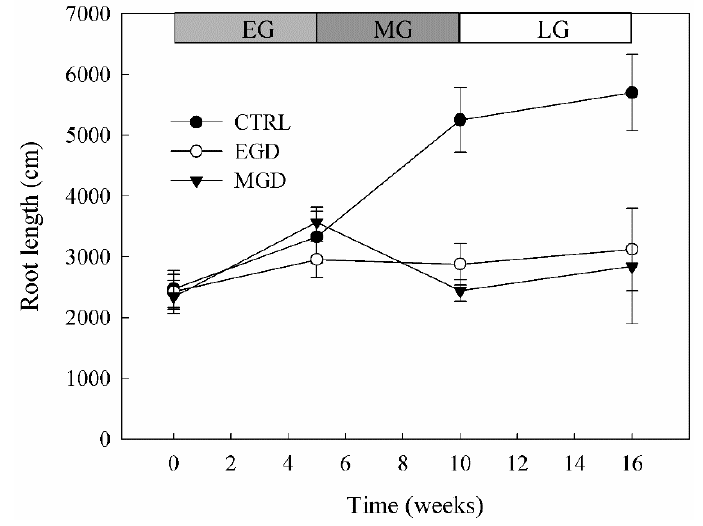
Figure 8. Root length of Mongolian pine saplings by treatment. CTRL indicates the control. EGD and MGD indicate drought stress treatment in the early- (EG) and mid- (MG) growing seasons, respectively. EG, MG and LG refer to the early- (weeks 1–5), mid- (weeks 6–10) and late- (weeks 11–18) growing season, respectively. Time indicates weeks from the beginning of the experiment. Bars indicate standard error ( n = 4).